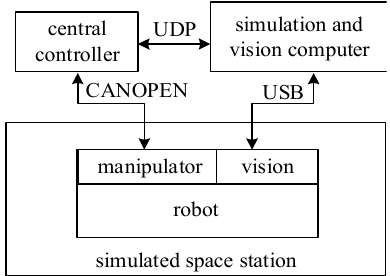
Figure 6. Control structure of the Beijing Astronaut Robot.